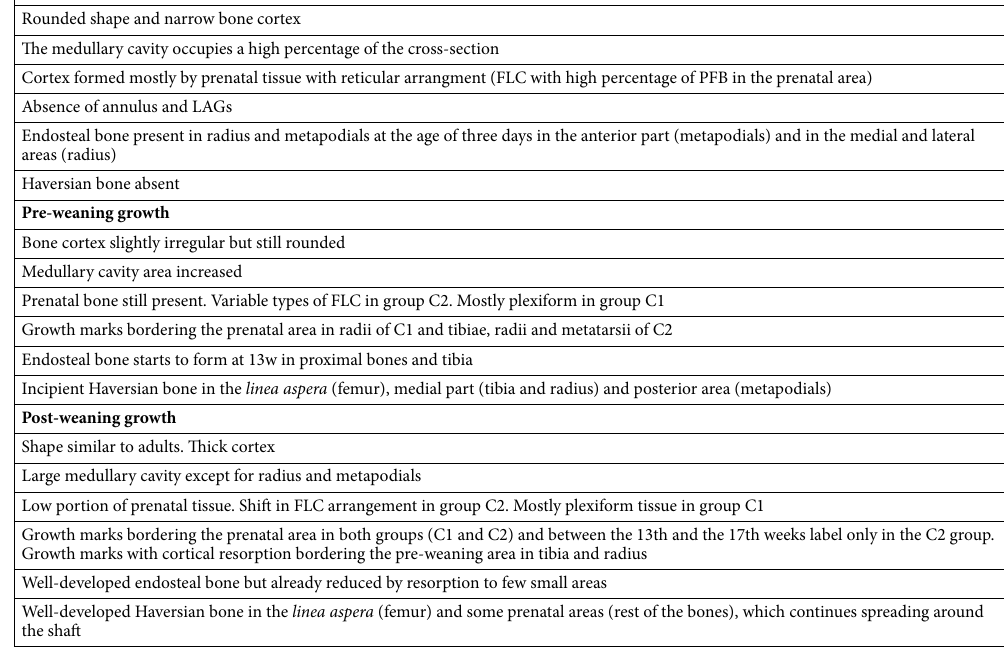
Table 1. Description of thin-sections. FLC fibrolamellar complex, PFB parallel fibered bone, LAG line of arrested growth, C1 calves left with their mothers, C2 hand-raised